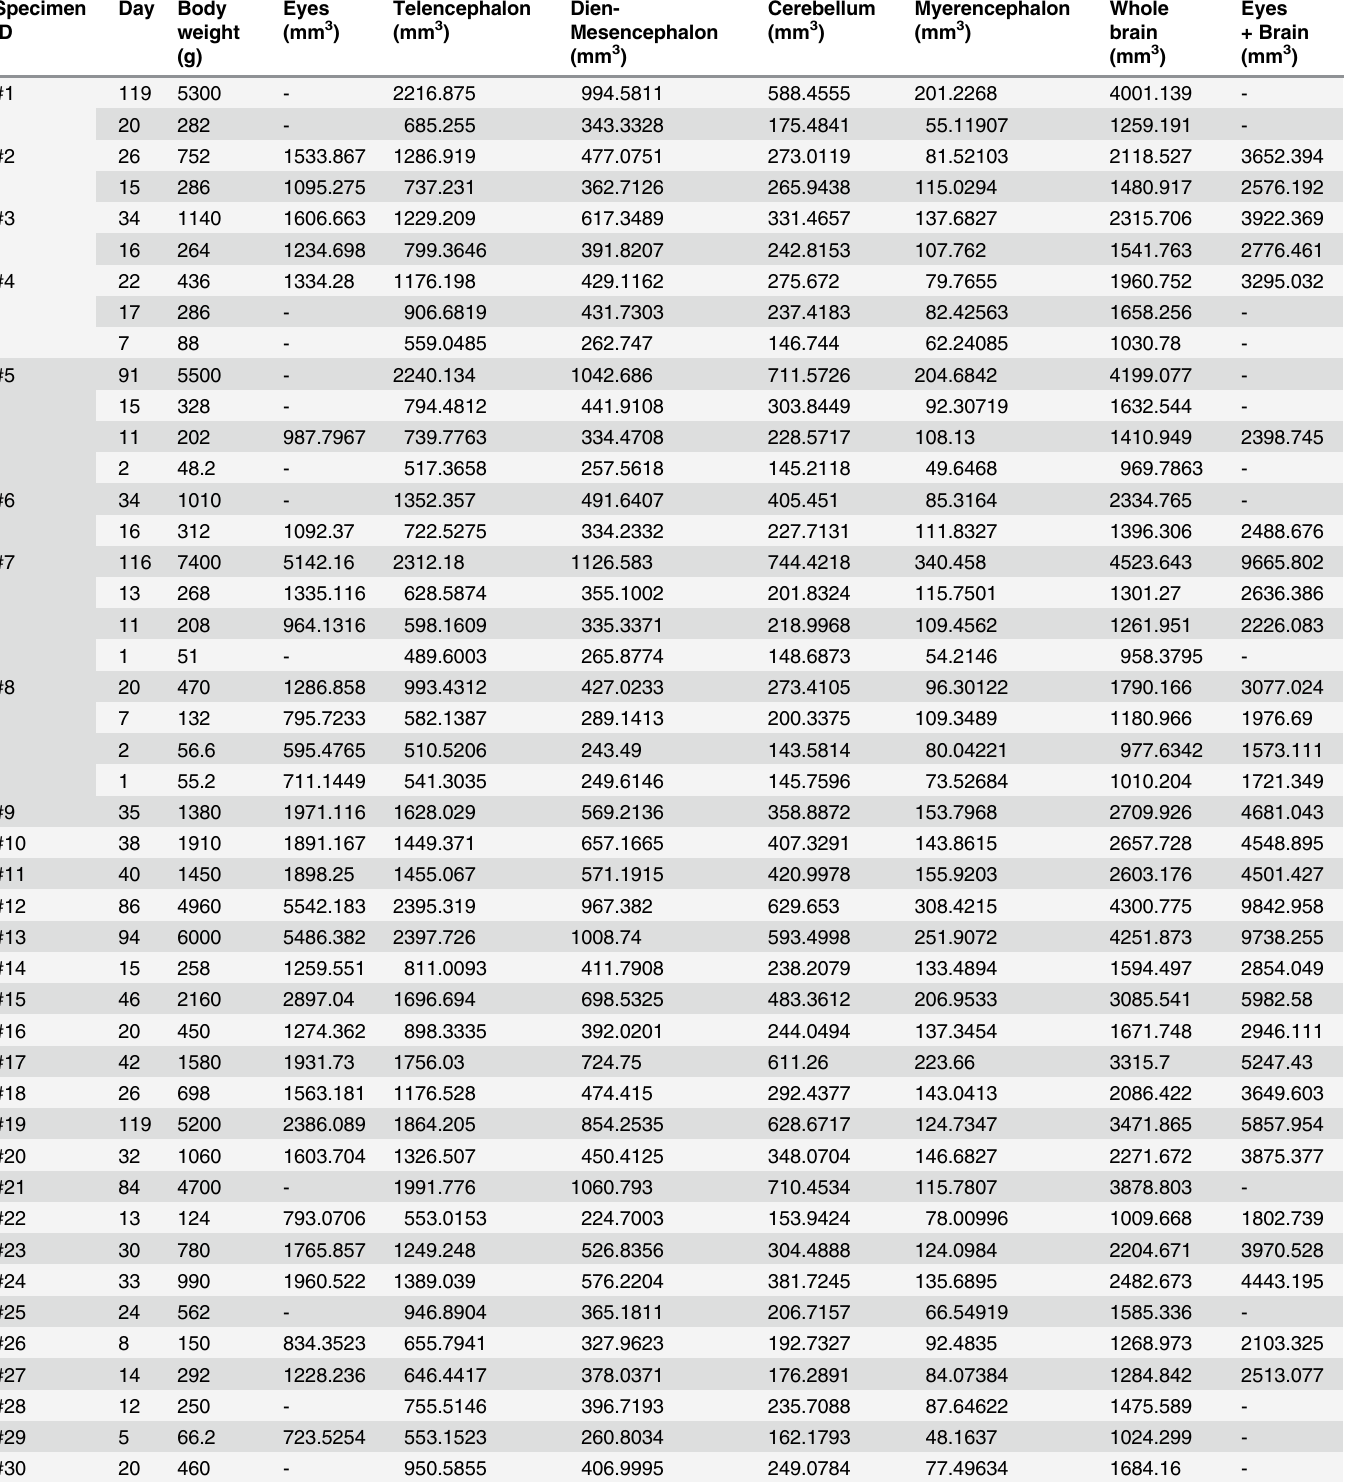
Table 1. Volume of the brain, including eyes, brain, brain and eyes, telencephalon, dien- and mesencephalon, and cerebellum of sampled specimens. Specimen